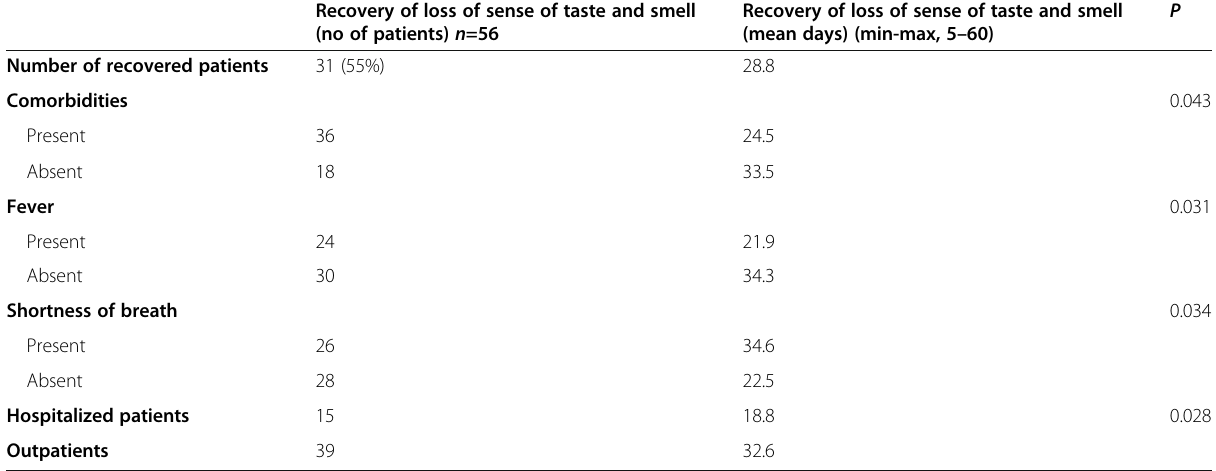
Table 3 Factors affecting the time to recovery of taste and smell dysfunction (only statistically significant factors are shown)